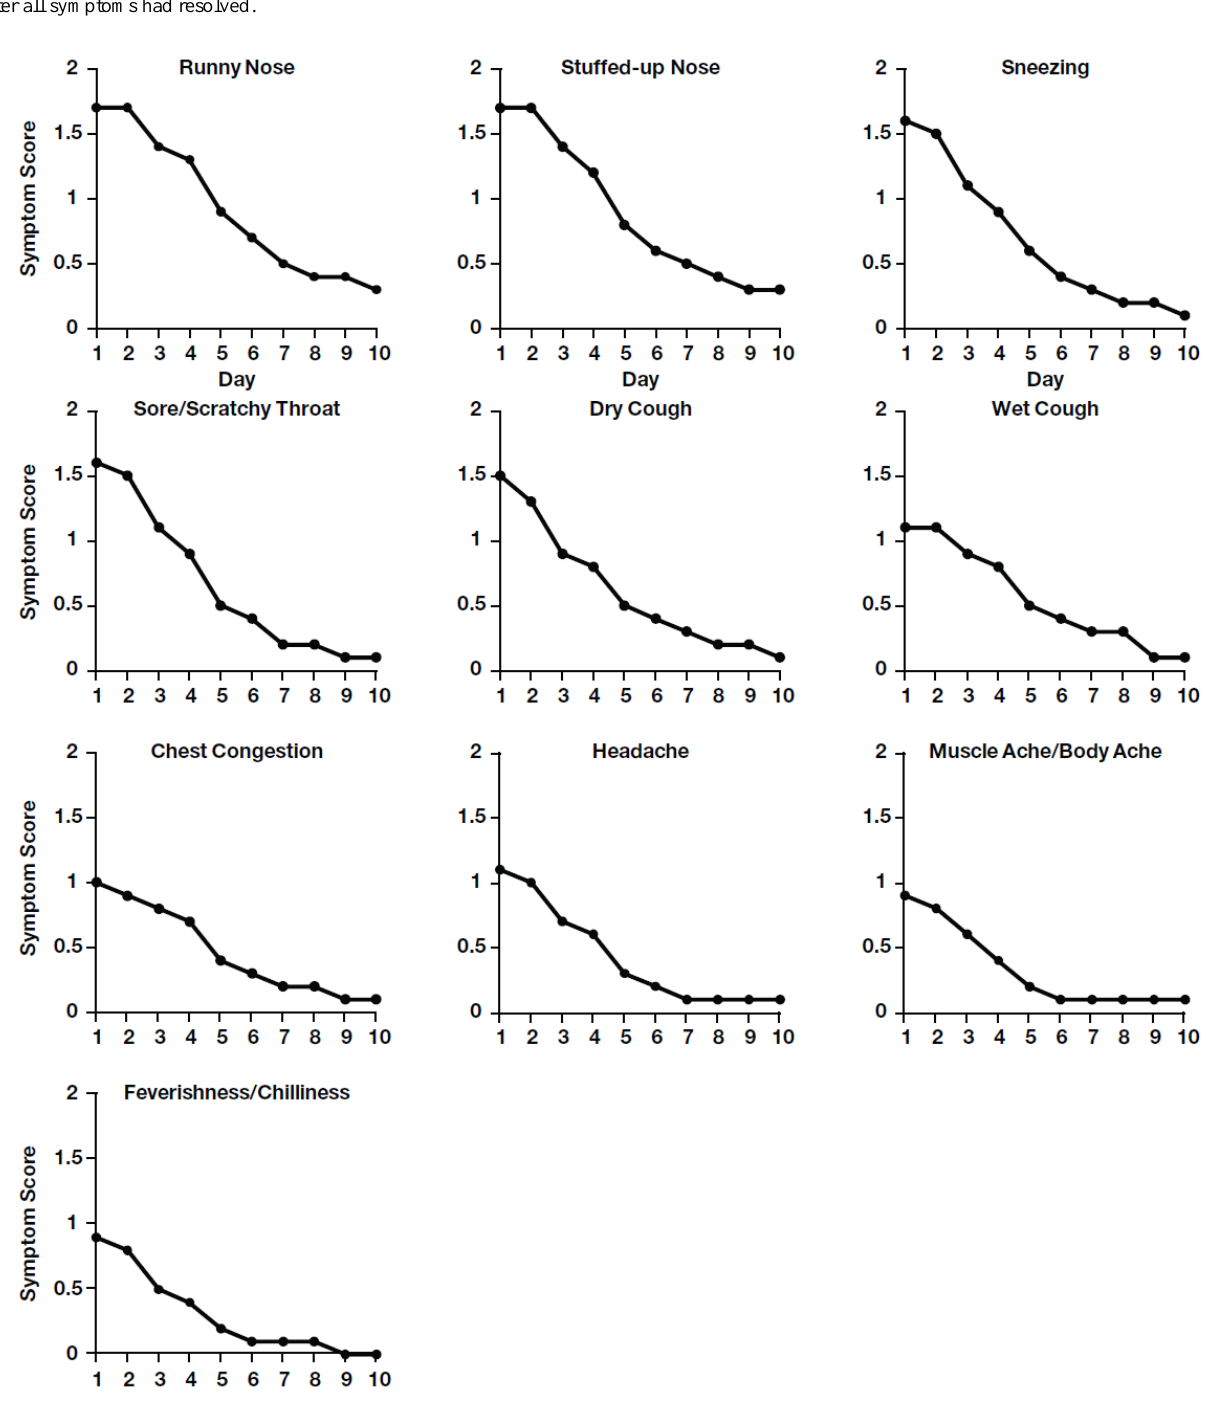
Figure 1. Average daily severity of individual cold symptoms. Parents of children with colds (n=134) were asked to score symptoms on a scale from 0 (not present) to 3 (severe). To calculate the average daily severity, a value of zero was assigned for those subjects who did not provide a symptom severity rating on a given day during the 10-day follow-up period because the parent was not required to complete the symptom severity questionnaire after all symptoms had